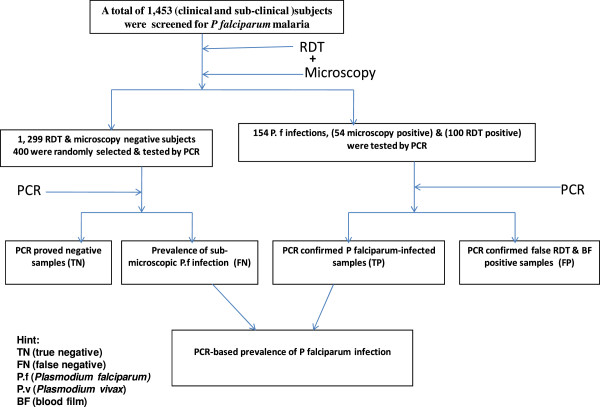
Study flow chart.